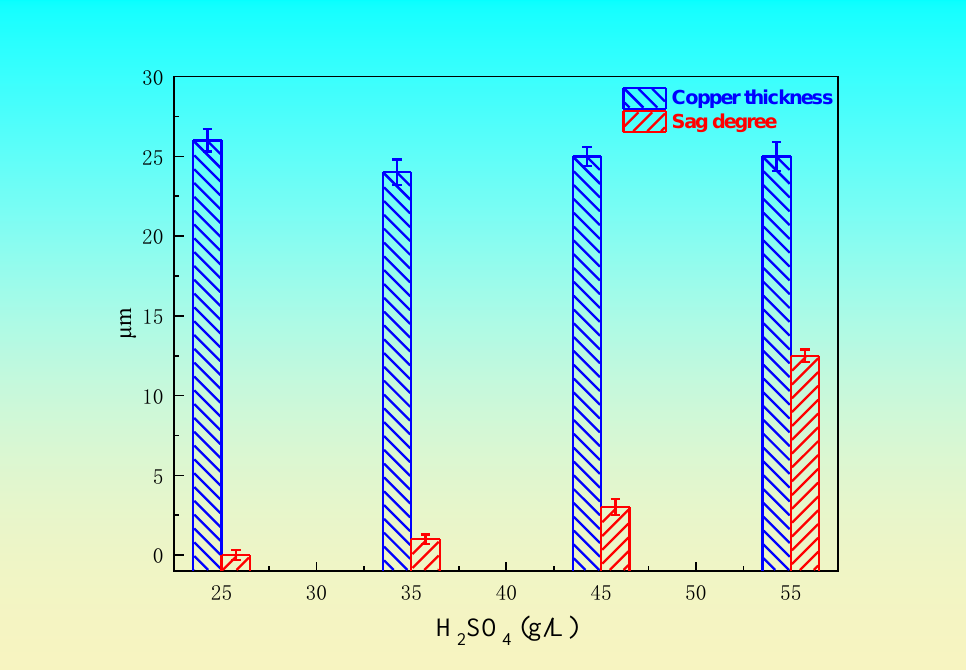
Figure 3. Effect of the sulfuric acid concentration on the sag and thickness. Based on the above test results, the suitable electroplating process and bath formula for a blind hole with a diameter of 100 μm and depth of 50 μm are as follows: 210~225 g/L CuSO 4 ·5H 2 O concentration, 25~35 g/L H 2 SO 4 concentration, 45~60 mg/L Cl − concen- tration, 0.8~1.2 mL/L brightener concentration, 10~16 mL/L leveling agent, 50~80 min electroplating time, 10~15 mL/L wetting agent concentration, and 1.4~1.7 A/dm 2 current density. According to the selected plating solution formula, blind hole 1 (depth diameter ratio of 1:2), with a diameter of 100 μm and a depth of 50 μm , and blind hole 2 (depth diameter ratio of 1.17:1), with a hole diameter of 60 μm and depth of 70 μm , were each plated under different levels of various factors. The optimum concentration of sulfuric acid was obtained by fixing the H 2 SO 4 at a concentration of 25 g/L, Cl - concentration of 45 mg/L, wetting agent concentration of 10 mL/L, brightener concentration of 1 mL/L, leveling agent of 15 mL/L, current density of 1.5 A/dm 2 , and electroplating time of 55 min, and changing the concentration of the copper sulfate. Then, by selecting the best concentration of copper sulfate, while the other factors remain unchanged, the best con- centration of sulfuric acid could be obtained through experiments. The hole filling rate changes of the two types of holes are shown in Figure 4 and Figure 5, respectively.